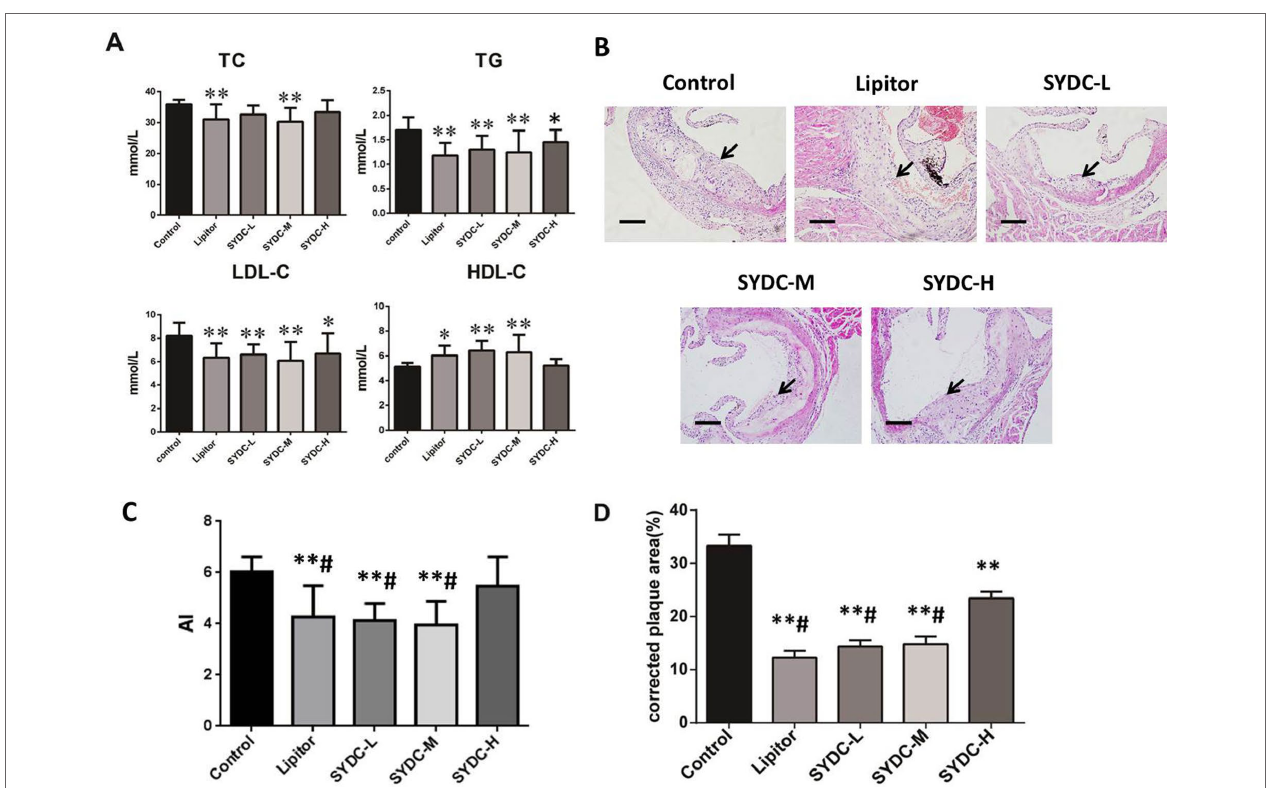
FIGURE 1 | Effects of Shen-Yuan-Dan Capsule (SYDC) on atherosclerosis. (A) Blood lipid total cholesterol (TC), triglycerides (TG), low-density lipoprotein cholesterol (LDL-C), and high-density lipoprotein cholesterol (HDL-C) levels in the control, Lipitor, SYDC-L, SYDC-M, and SYDC-H groups (n = 10). (B) Representative images of H&E staining. Black arrows indicate atherosclerotic plaques. Tissues were examined using light microscopy (scale bars = 100 μm). (C) AI values in the control, Lipitor, SYDC-L, SYDC-M, and SYDC-H groups (n = 10). (D) Quantitation of atherosclerotic plaques in the different groups (n = 8). * P < 0.05 vs. control group; ** P < 0.01 vs. control group; # P < 0.01 vs. SYDC-H